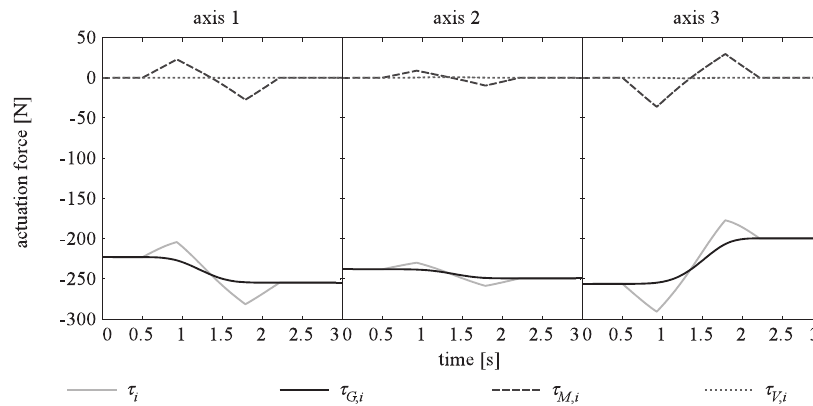
Figure 10. Di ff erent contributions to the total actuation e ff orts during a motion along a line.